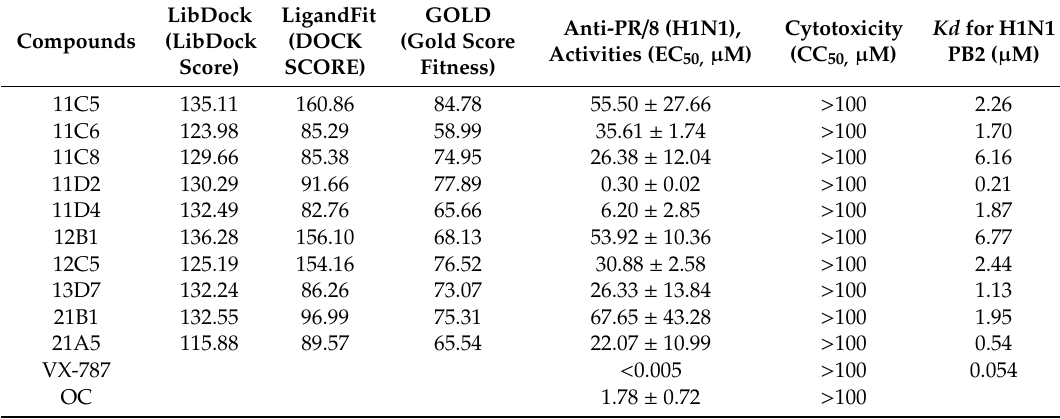
Figure 2. The structures of the 10 experimentally validated compounds. Table 1. The structure, docking scores, anti-H1N1-PR/8 activities, cytotoxicity, and K d of the active compounds.